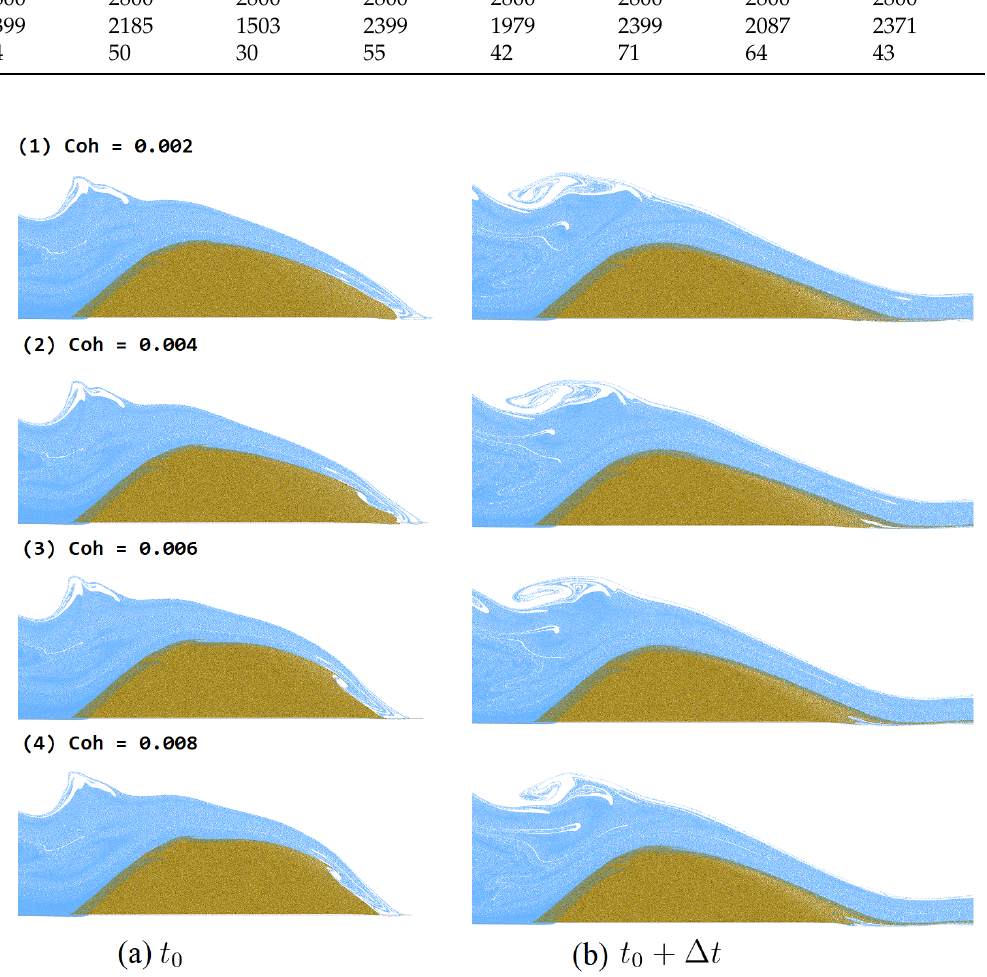
Figure 4. Overtopping dam breach simulation with different cohesion at timestamps ( a ) t 0 and ( b ) t 0 + ∆ t